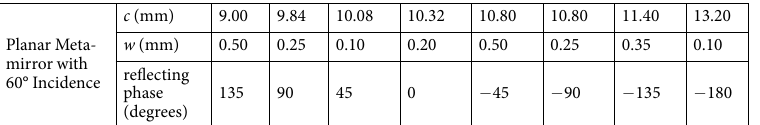
Planar Meta- mirror with 60° Incidence